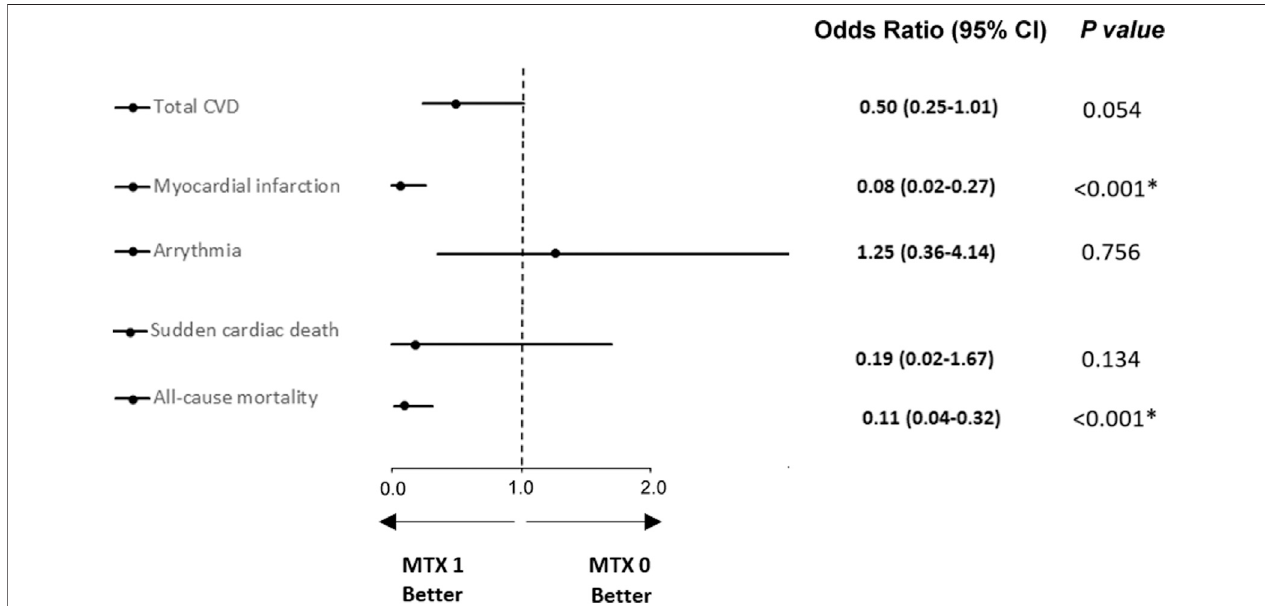
FIGURE 4 | Logistic regression analysis after propensity score matching for CVDs and all-cause mortality between groups ofRA patients treated (MTX 1 group) or non-treated (MTX 0 group) with adjustment for le fl unomide, beta blockers, and other bDMARD treatments. * Values are statistically signi fi cant ( p < 0.05). CVD, cardiovascular disease; MTX 1, patients treated with MTX at the time of data collection; MTX 0, patients without MTX treatment at the time of data collection.